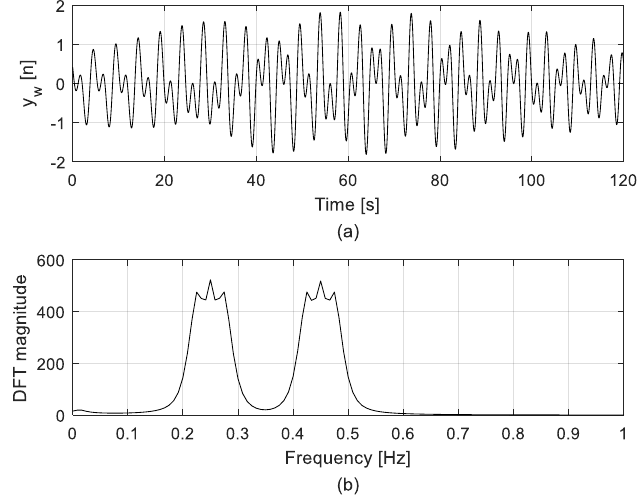
Figure 1. Synthetic oscillation data of the two modes in the simulation with a 50 dB SNR: ( a ) oscillation data with an interval of 2 minutes; ( b ) DFT magnitude for data between 0 and 1 Hz.